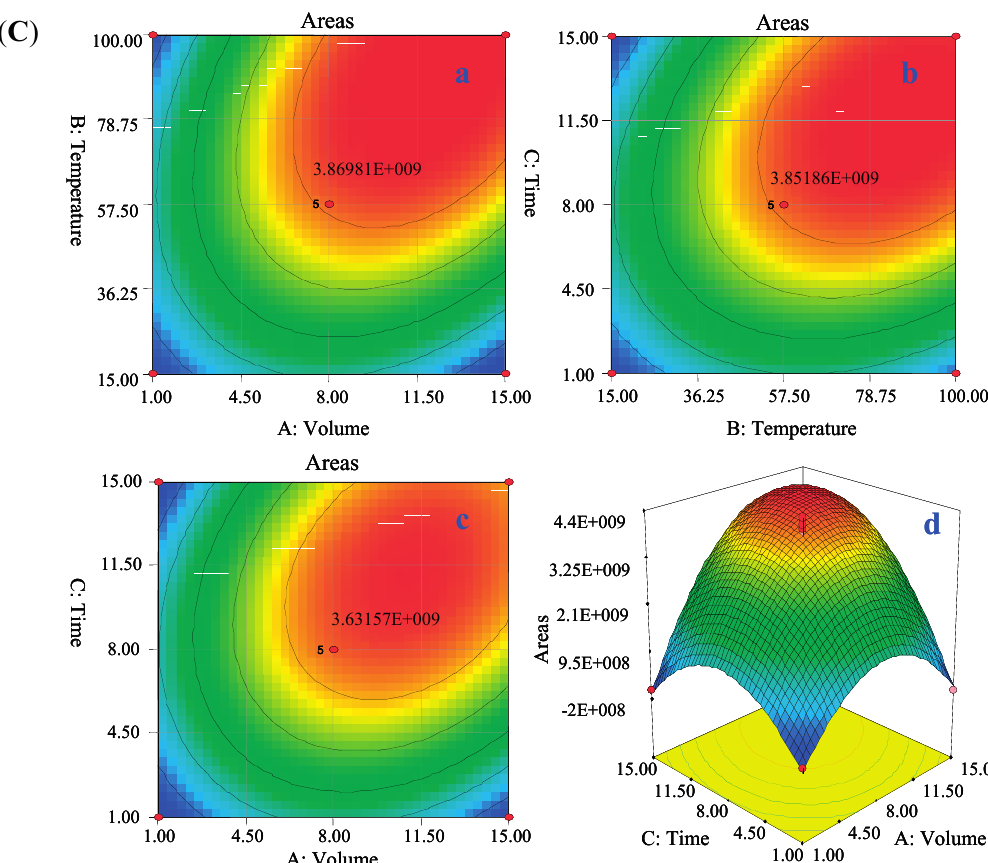
Figure 1. Optimization of precolumn methylesterified (PME) by Box–Behnken design (BBD)/GC–EI-qMS. ( A ) GC–EI-qMS chromatogram of the 25 fatty acid methyl esters (FAMEs) in suet oil (SO) sample under total ion chromatogram (TIC) mode. ( 1 ) Dodecanoic acid, methyl ester (DODME), ( 2 ) Methyl myristoleate, methyl ester, ( 3 ) Methyl 12-methyl-tridecanoate, methyl ester, ( 4 ) Tridecanoic acid, 12-methyl-, methyl ester, ( 5 ) Methyl tetradecanoate, methyl ester (MTEME), ( 6 ) Pentadecanoic acid, methyl ester (PENME), ( 7 ) ( Z )-9-Hexadecenoic acid, methyl ester (9-HEME), ( 8 ) Hexadecanoic acid, ( 10 ) cis -10-Heptadecenoic acid, methyl ester, ( 11 ) Heptadecanoic acid, methyl ester (HEPME), ( 12 ) ( Z , Z )-9,12-Octadecadienoic acid, methyl ester (9,12-OCME), ( 13 ) Methyl 9- cis ,11- trans -octadecadienoate methyl ester, ( 14 ) Methyl 10- trans ,12- cis -octadecadienoate, ( 15 ) 9-Octadecenoic acid ( E )-, methyl ester (9-OCME), ( 16 ) 9-Octadecenoic acid ( Z )-, methyl ester, ( 17 ) 11-Octadecenoic acid, methyl ester, ( 18 ) Octadecanoic acid, methyl ester (OCTME), ( 19 ) cis -10-Nonadecenoic acid, methyl ester, ( 20 ) 10-Nonadecenoic acid, methyl ester, ( 21 ) Cyclopropaneoctanoic acid, 2-octyl-, methyl ester, ( 22 ) Nonadecanoic acid, methyl ester, ( 23 ) Methyl 8,11,14-eicosatrienoate, methyl ester, ( 24 ) cis -11-Eicosenoic acid, methyl ester, of representative blank samples under TIC mode; ( C ) Response surface plots (3-D) and contour (2-D) showing the total peaks areas with different methyl esterified condition. ( a ) 2-D panel of temperature-volum, ( b ) 2-D panel of time-temperature, ( c ) 2-D panel of time-volum, ( d ) 3-D response surface